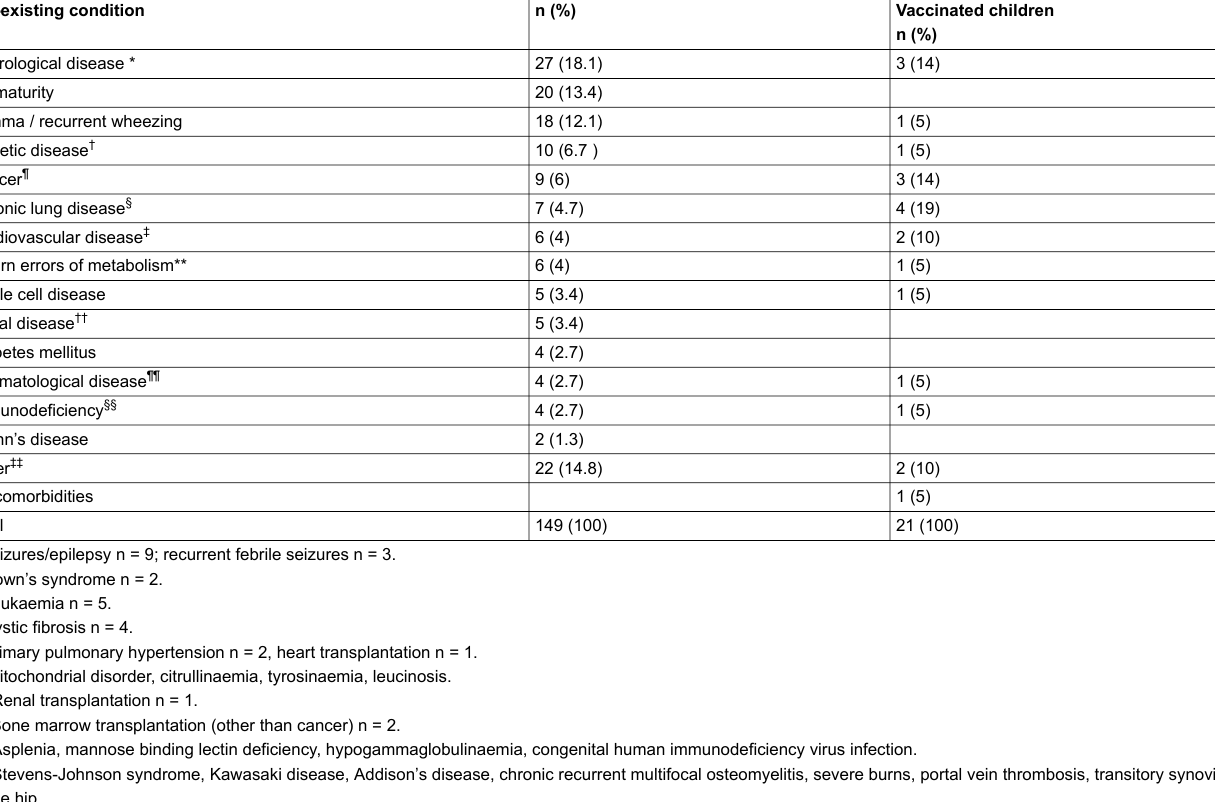
Table 1: Underlying medical conditions in 126 of 326 Swiss children hospitalised with pandemic influenza A/H1N1/09 virus infection. (>1 condition reported in some children.) Pre-existing